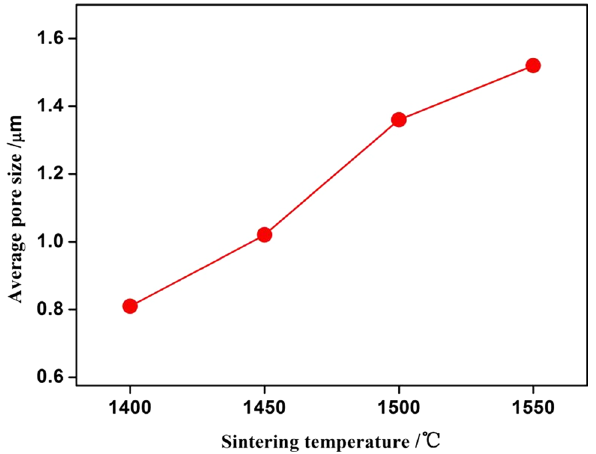
Fig. 5 Effect of the sintering temperature on the mean pore size of supports sintered at different temperatures (1400–1550 °C)